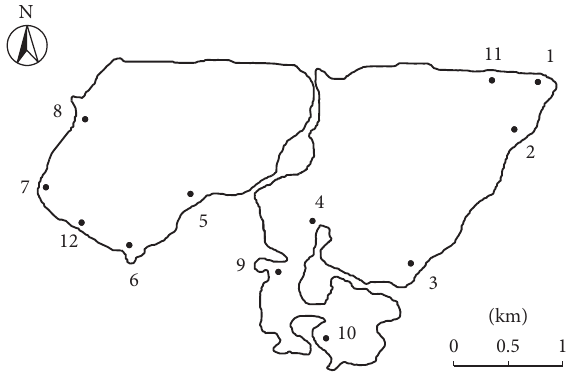
Figure 1: Sample collection